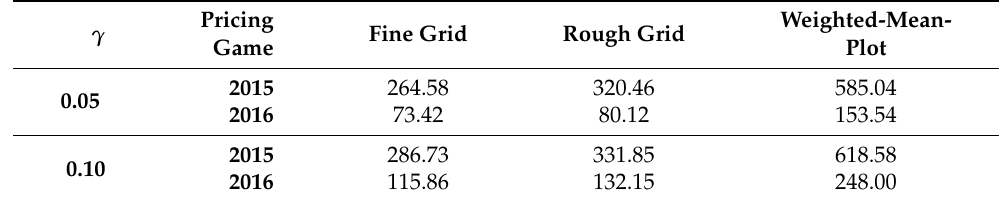
Table 2. Computing time (s) to calculate the exact concordance probability C ≈ model on the 2015 and 2016 pricing game dataset. This is done for the fine grid, rough grid and weighted-mean-plot approach.